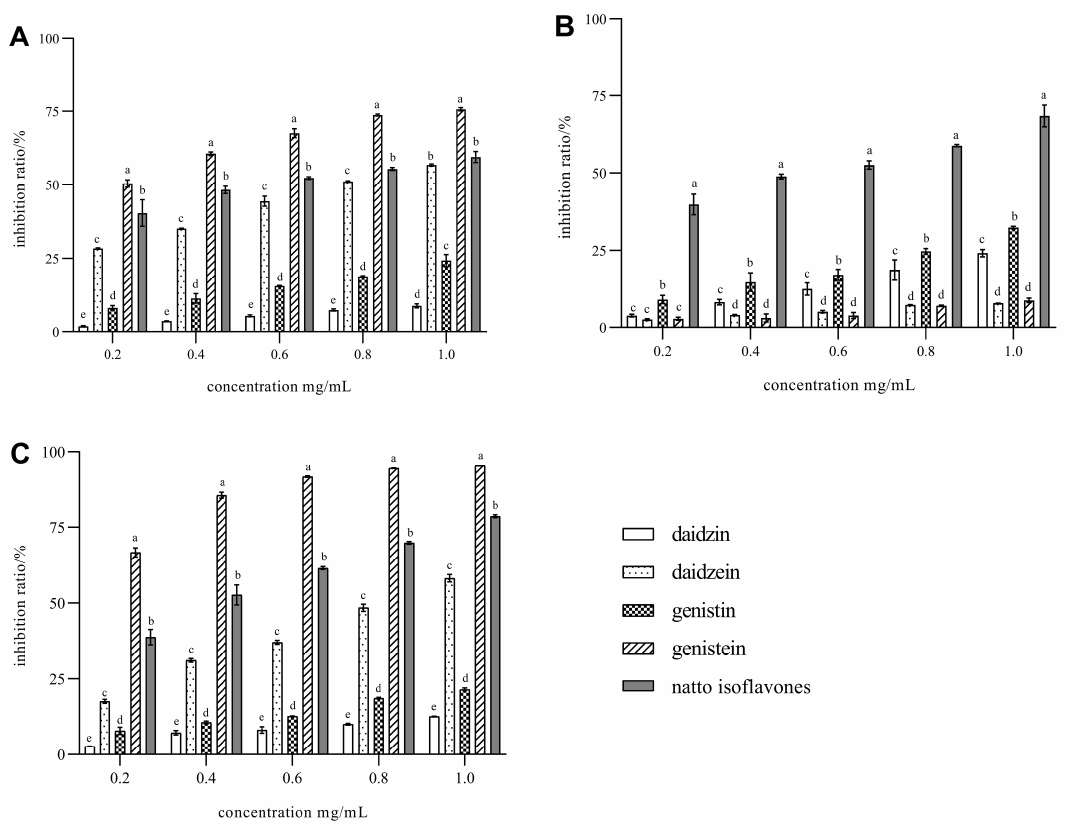
Figure 7. Determination of AGEs inhibition rate in vitro model. ( A ) fructose-BSA model; ( B ) lactose– lysine system; ( C ) MGO-BSA system. Data are presented as the means ± SD of three replications. Different letters represent significant differences ( p < 0.05).